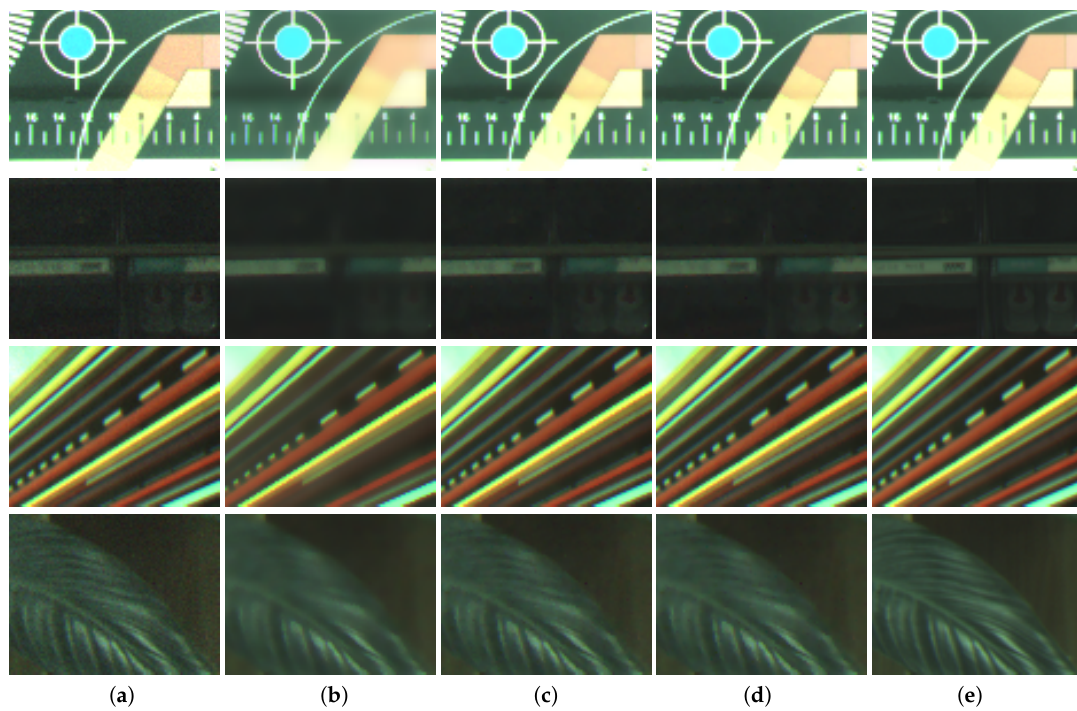
Figure 6. Qualitative comparison: ( a ) input images, the results of ( b ) the conventional bilateral filter, ( c ) the proposed NABF, ( d ) B-NABF, and ( e ) the ground